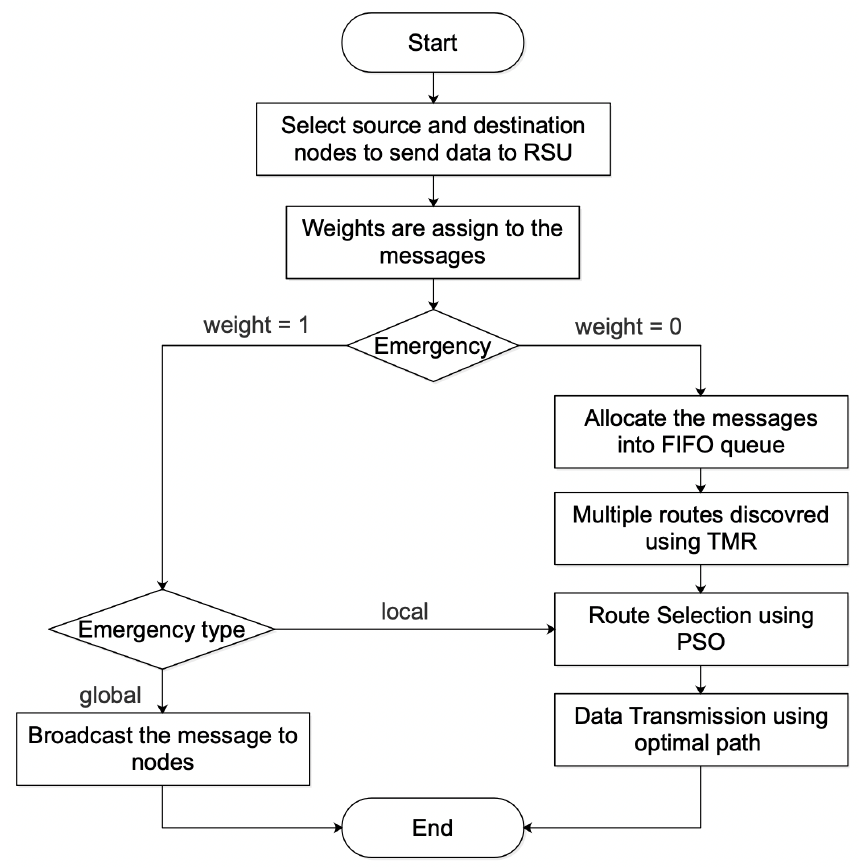
Figure 3. Flow diagram of the